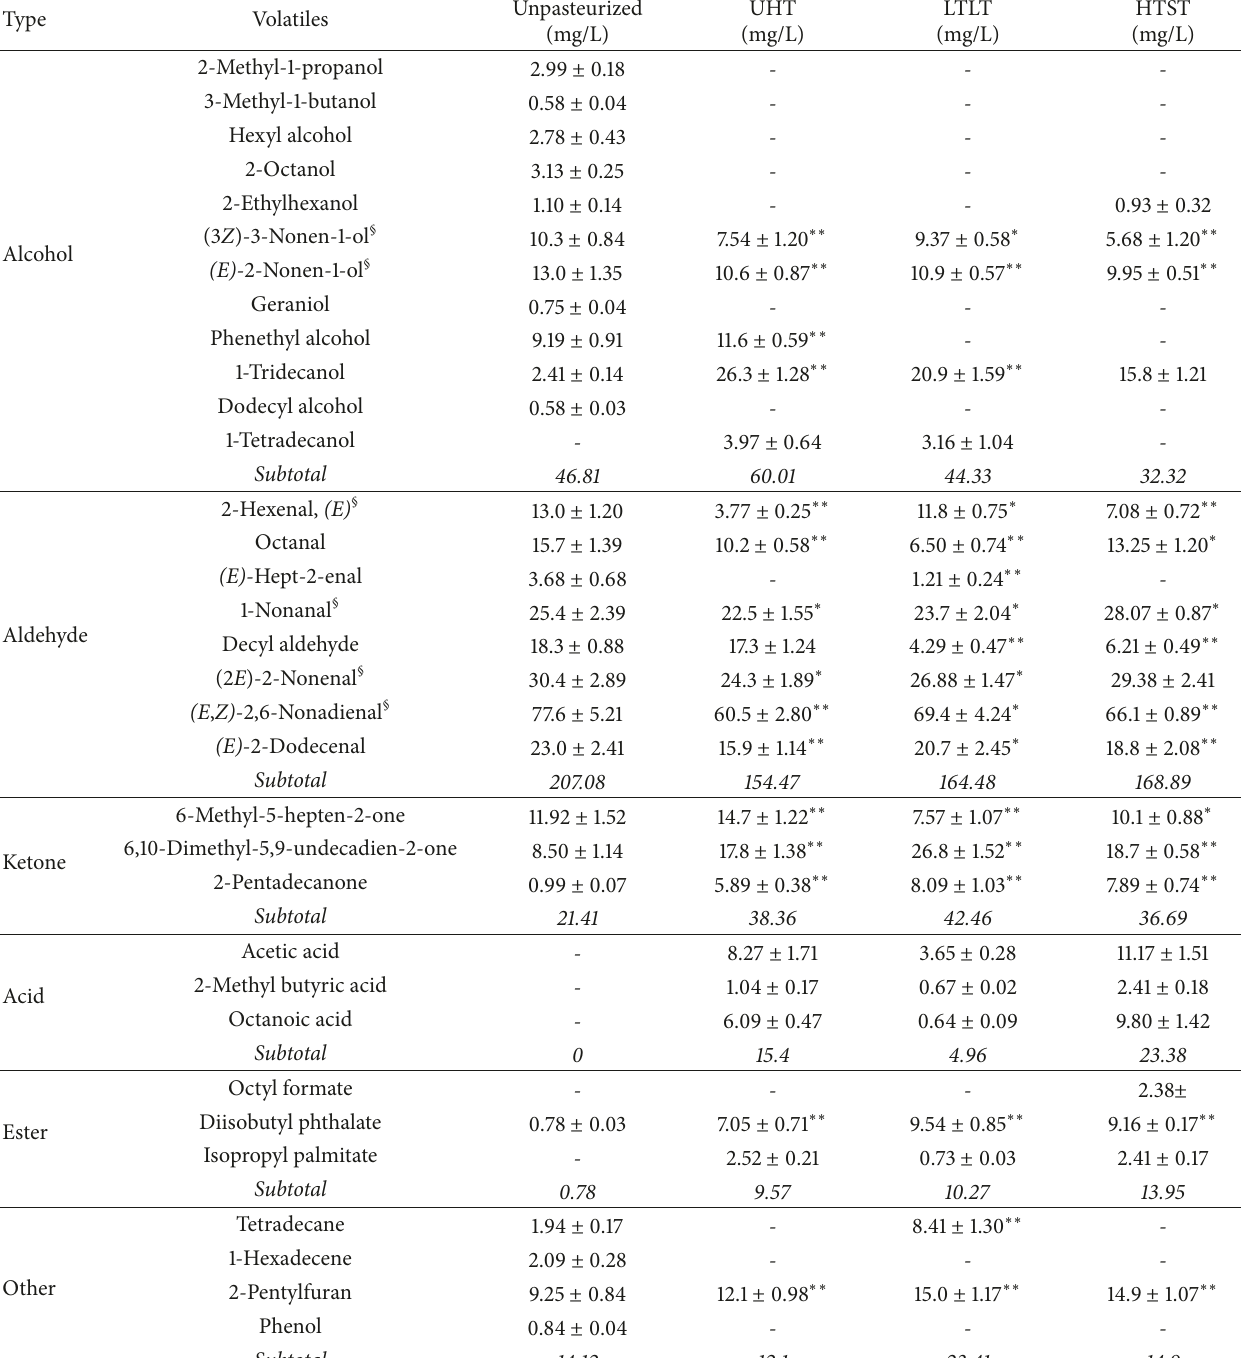
Table 1: Volatiles detected in the watermelon